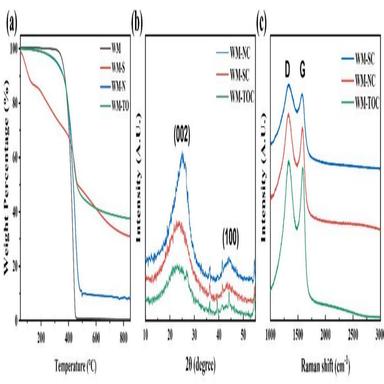
(a) TGA thermograms of WMs before and after three different pretreatments; (b) XRD diffraction pattern; and (c) Raman spectra of pretreated WMs after carbonization.